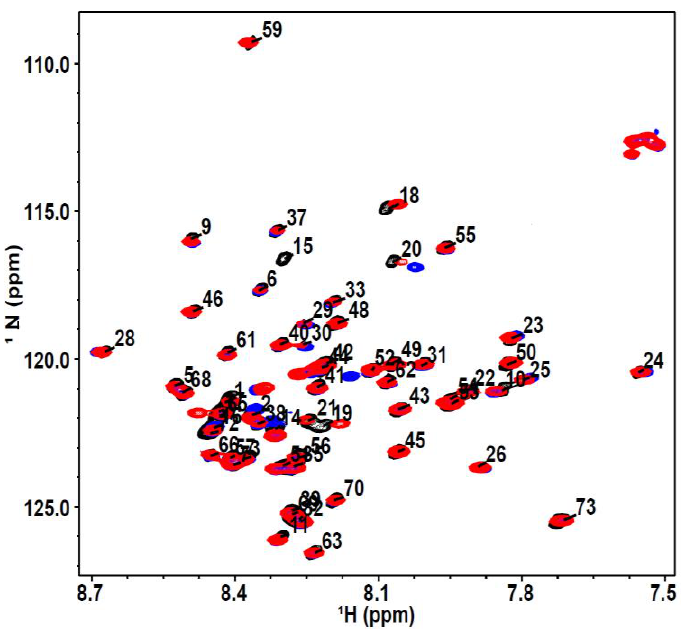
Figure 1. p53TAD and phosphomimics. 1 H- 15 N HSQC spectra overlay of 15 N-labeled p53TAD (black), 15 N-labeled S15D mutant (red), 15 N-labeled S15D/T18E mutant (blue).